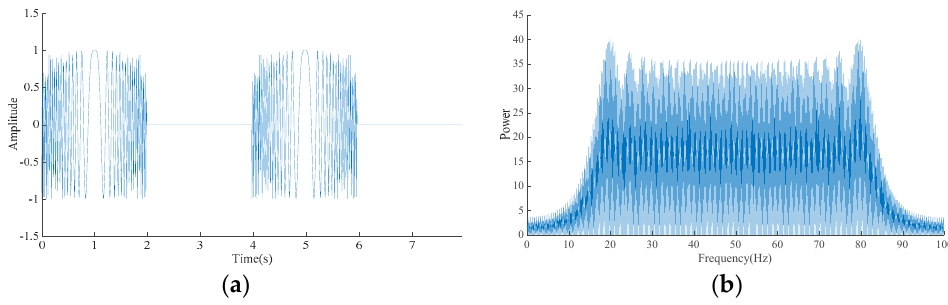
Figure 4. LFM pulse characteristic diagram: ( a ) time distribution; ( b ) frequency domain.